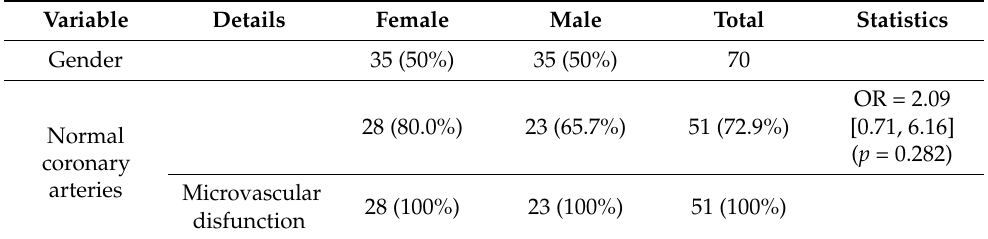
Table 2. Association of LBBB with the presence of normal coronary arteries detected by angiography.